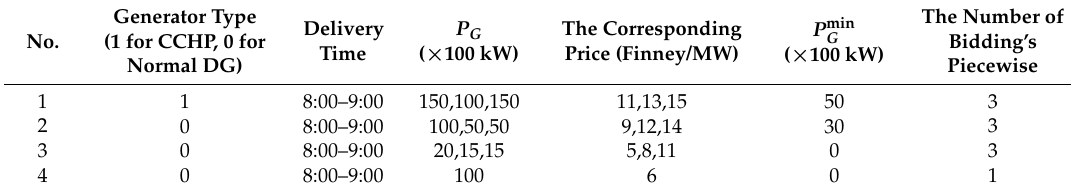
Table 7. Sellers’ parameters.